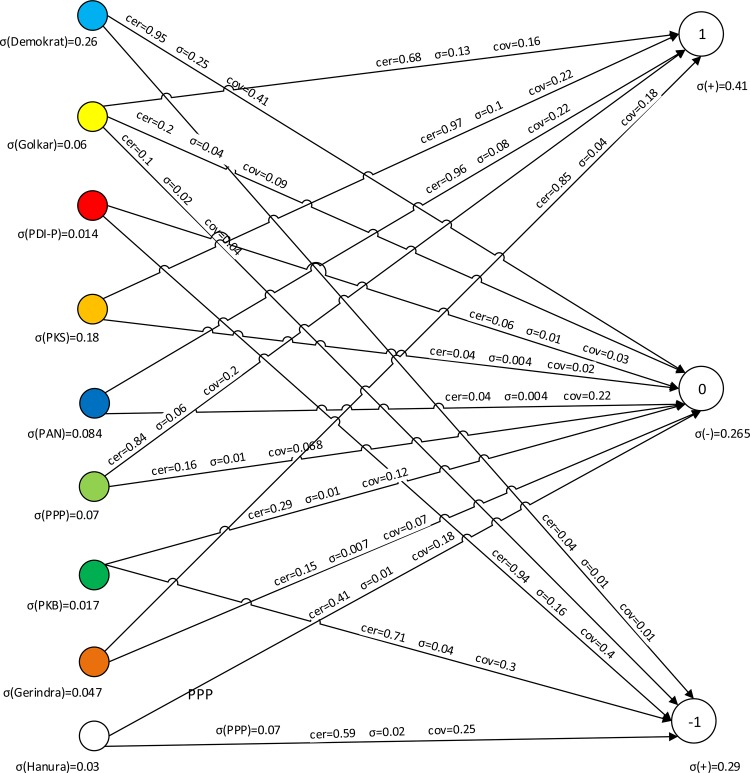
Flow graph for Table 21.